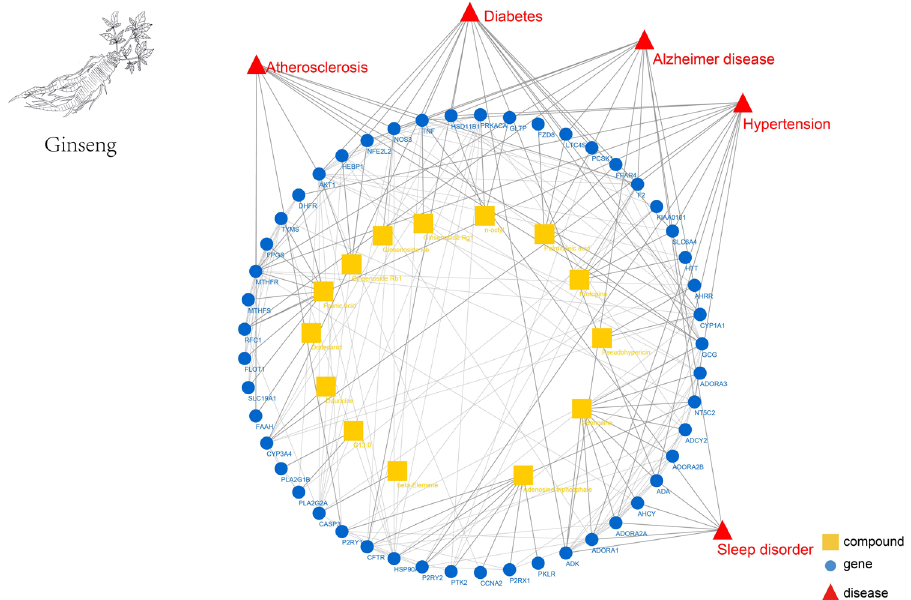
Figure 4. The pharmacology network generated for ginseng. The innermost circle represents the compounds collected from the ginseng, the circle in the middle represented the related genes of compounds from ginseng, the outermost layer represented the diseases that were related to the genes. Node: yellow square, compound; blue circle, gene; red triangle, disease. Line: the line between yellow square and blue circle, compound-gene links; the line between blue circle and red triangle, potential links between gene and disease. The ginseng in the figure was drawn in-house according to the real